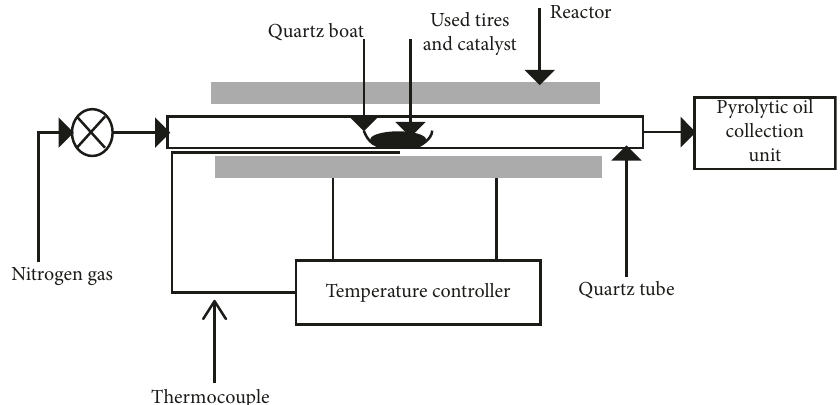
Figure 1: Schematic of the experimental setup for the pyrolysis of used Table 2: Standard methods for physical property analysis.